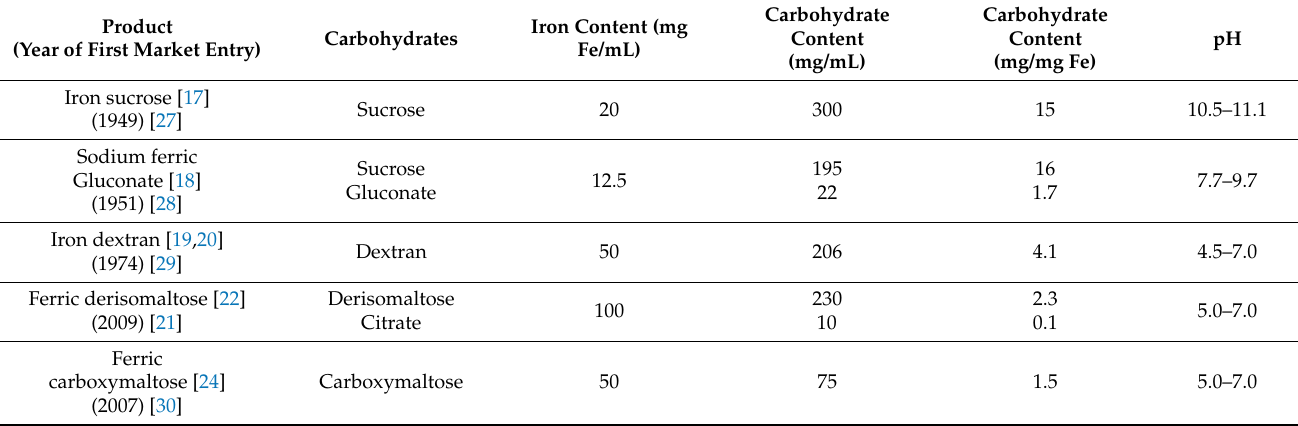
Table 2. Composition of main iron carbohydrate preparations on the market (approximate